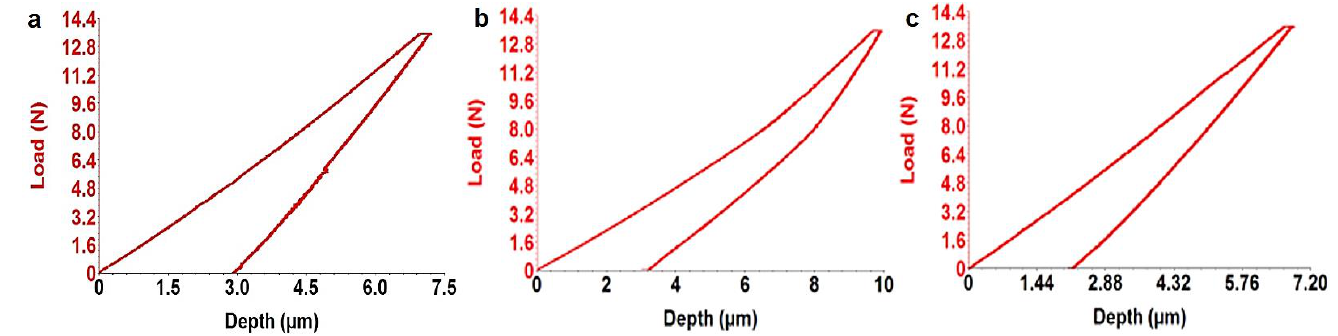
Figure 6. Micro-indentation graphic: ( a ) S1-HA, ( b ) S2-HA, ( c ) S3-HA.